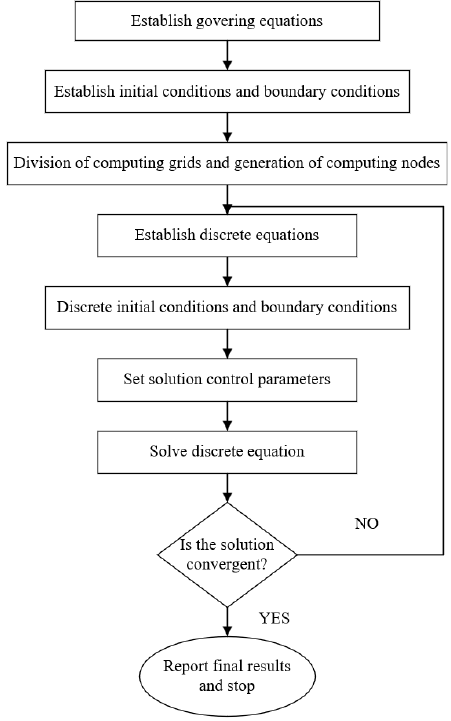
Figure 5. Algorithm flowchart of CFD.